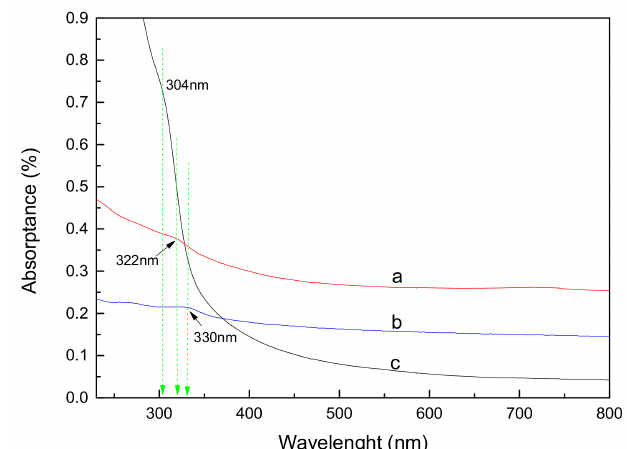
Figure 4. UV-Vis absorption spectra of ZnS-GQDs composites (a), ZnS-graphene composites (b) and pure ZnS